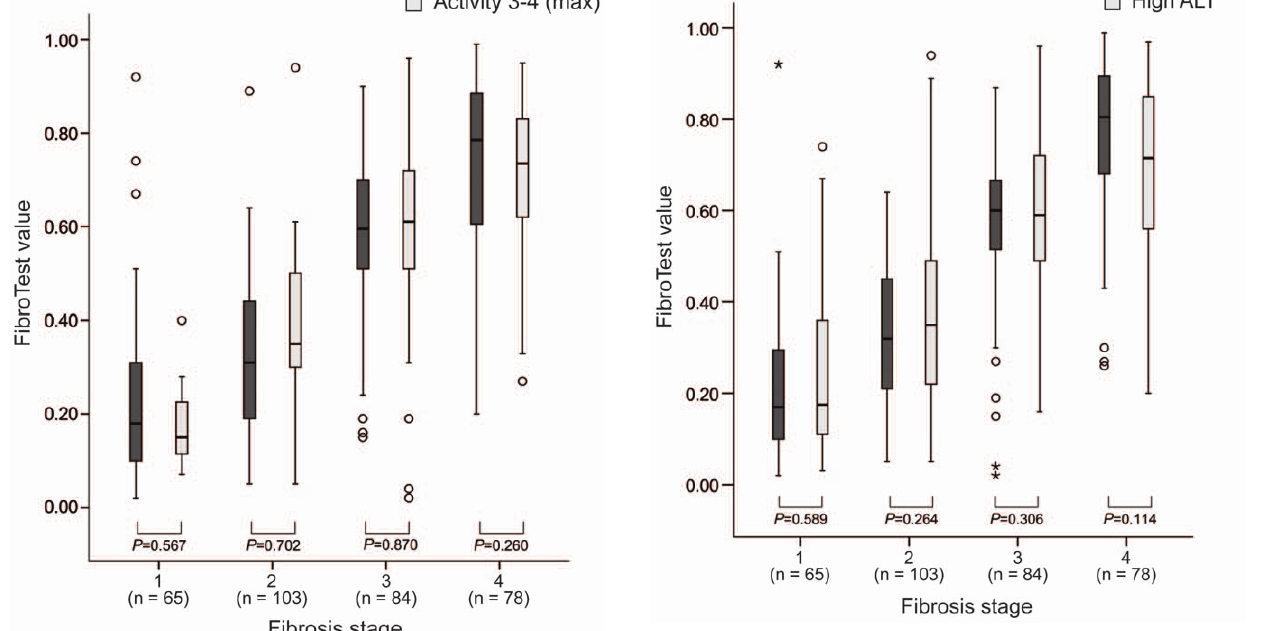
Table S1 Factors affecting discordance between FT and